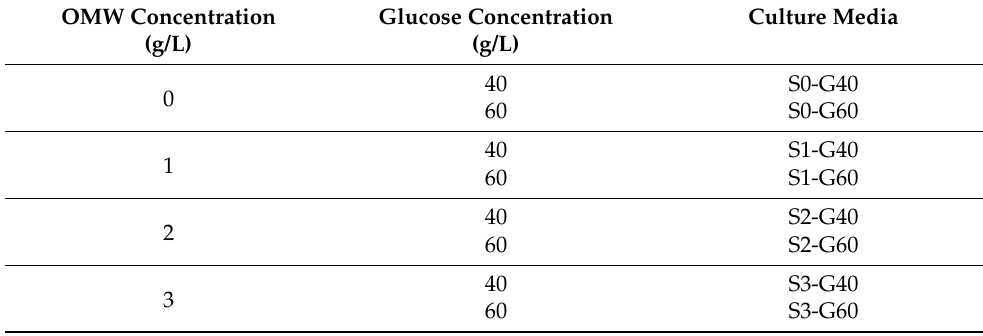
Table 2. Composition of the substrates used in liquid state fermentation experiments (before